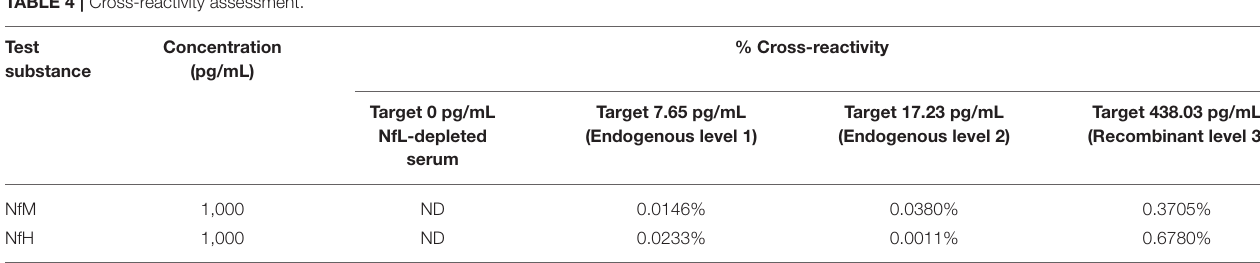
TABLE 4 | Cross-reactivity